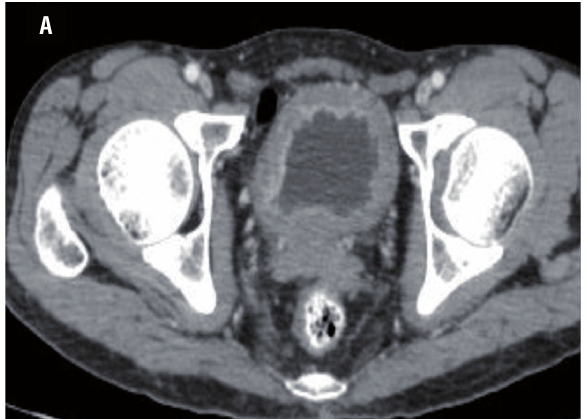
figure 1 - CT showing enhancing soft tissue lesion in the urinary bladder suggesting neoplastic